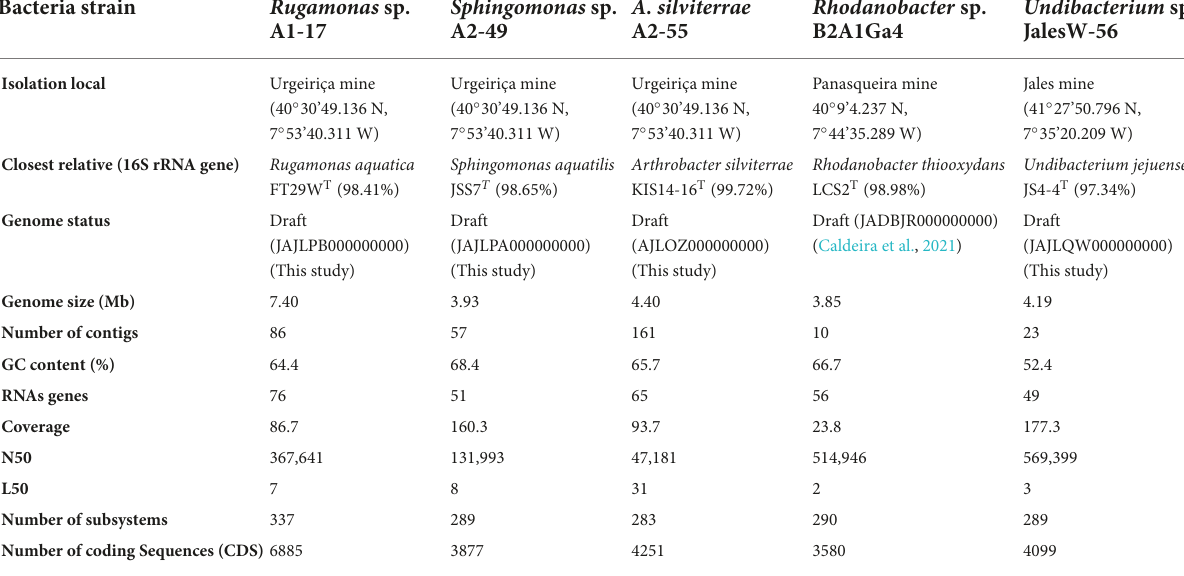
TABLE 1 Isolation local and genomic features of the mine bacterial strains. Bacteria